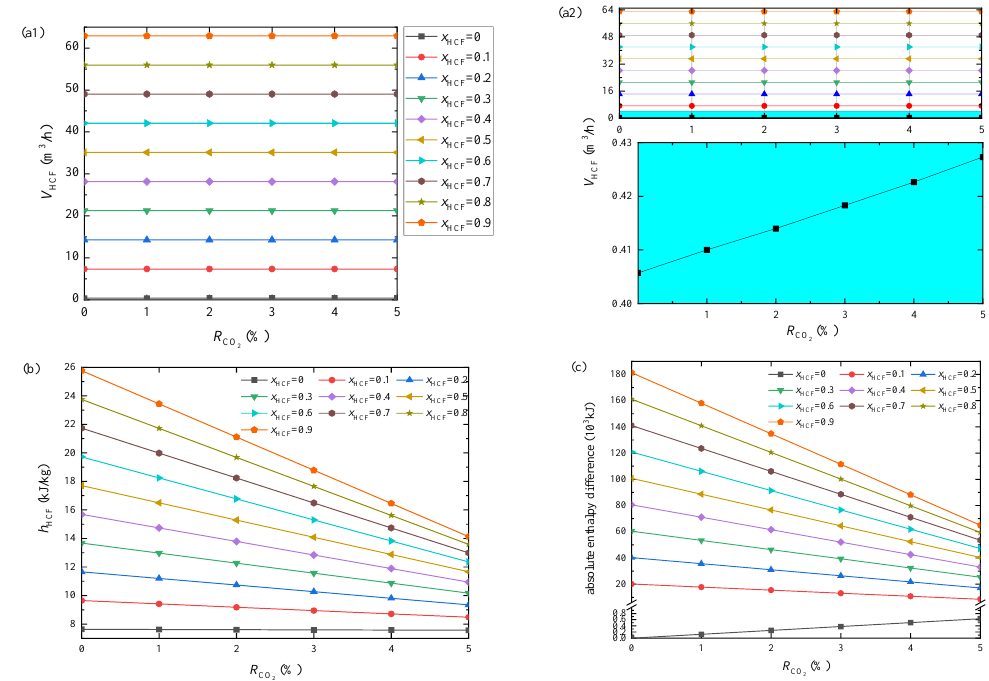
Figure 9. Variation curves of wellhead productivity parameters of heat carrier with R CO2 under different steam quality: ( a1 , a2 ) mass flow rate, ( b ) enthalpy and ( c ) absolute enthalpy difference.